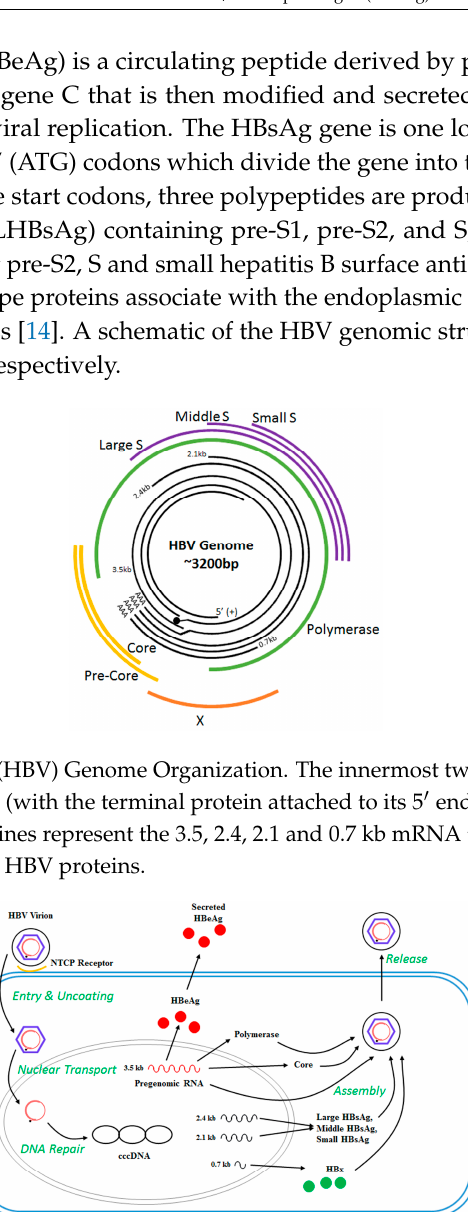
Table 1. Genes and Proteins encoded by Hepatitis B Virus (HBV).